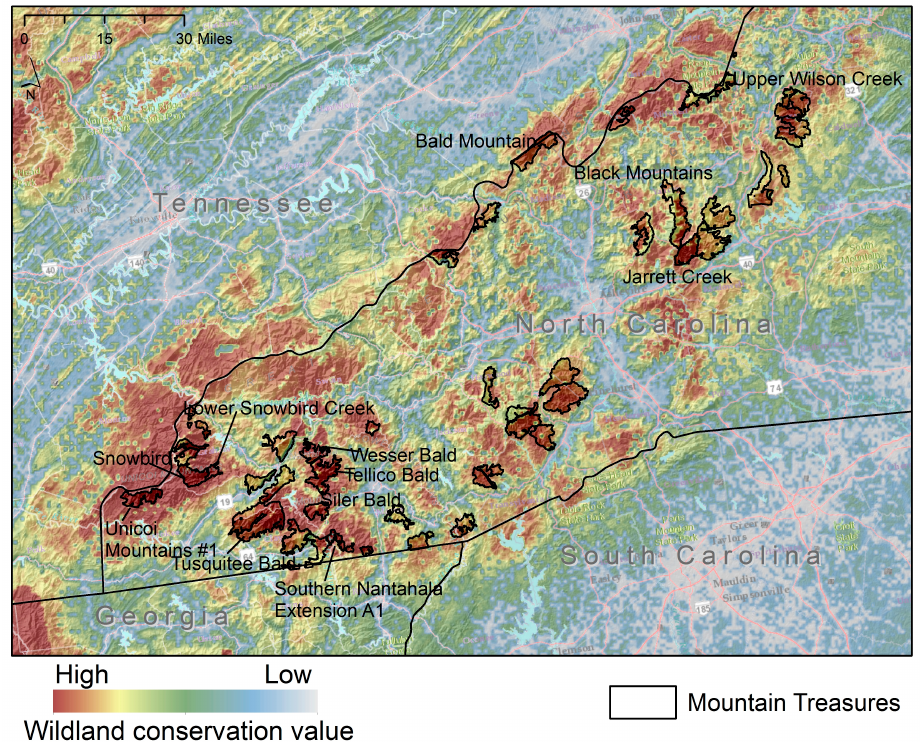
Figure 7. The composite wildland conservation value of Belote et al. (2017) that combined the indices of ecological integrity, connectivity, ecosystem representation, and biodiversity priorities into one map.